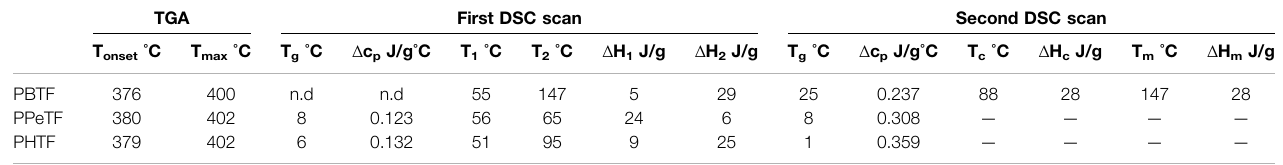
TABLE 1 | Thermal characterization data (TGA and DSC) of the thiophene-based polymers described in this work. TGA First DSC scan Second DSC scan T onset °